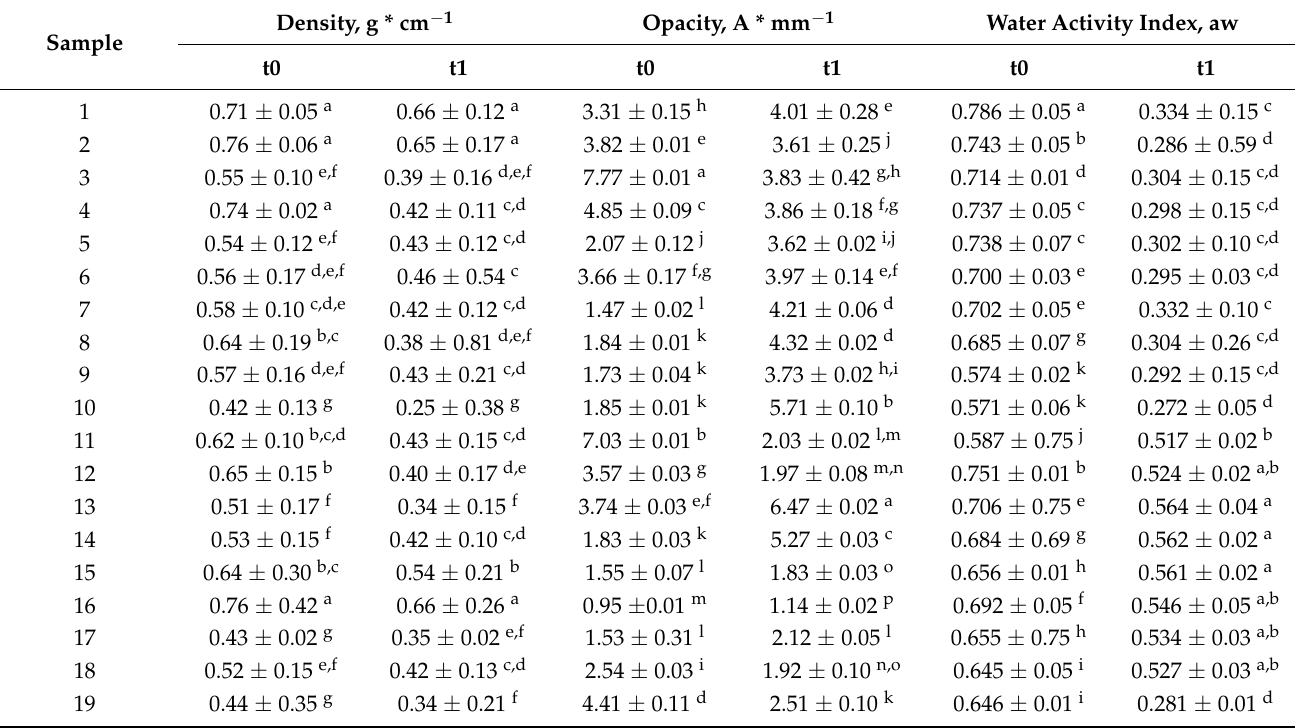
Table 1. Optical parameters and water activity index at the time of development (t0) and after one year of storage